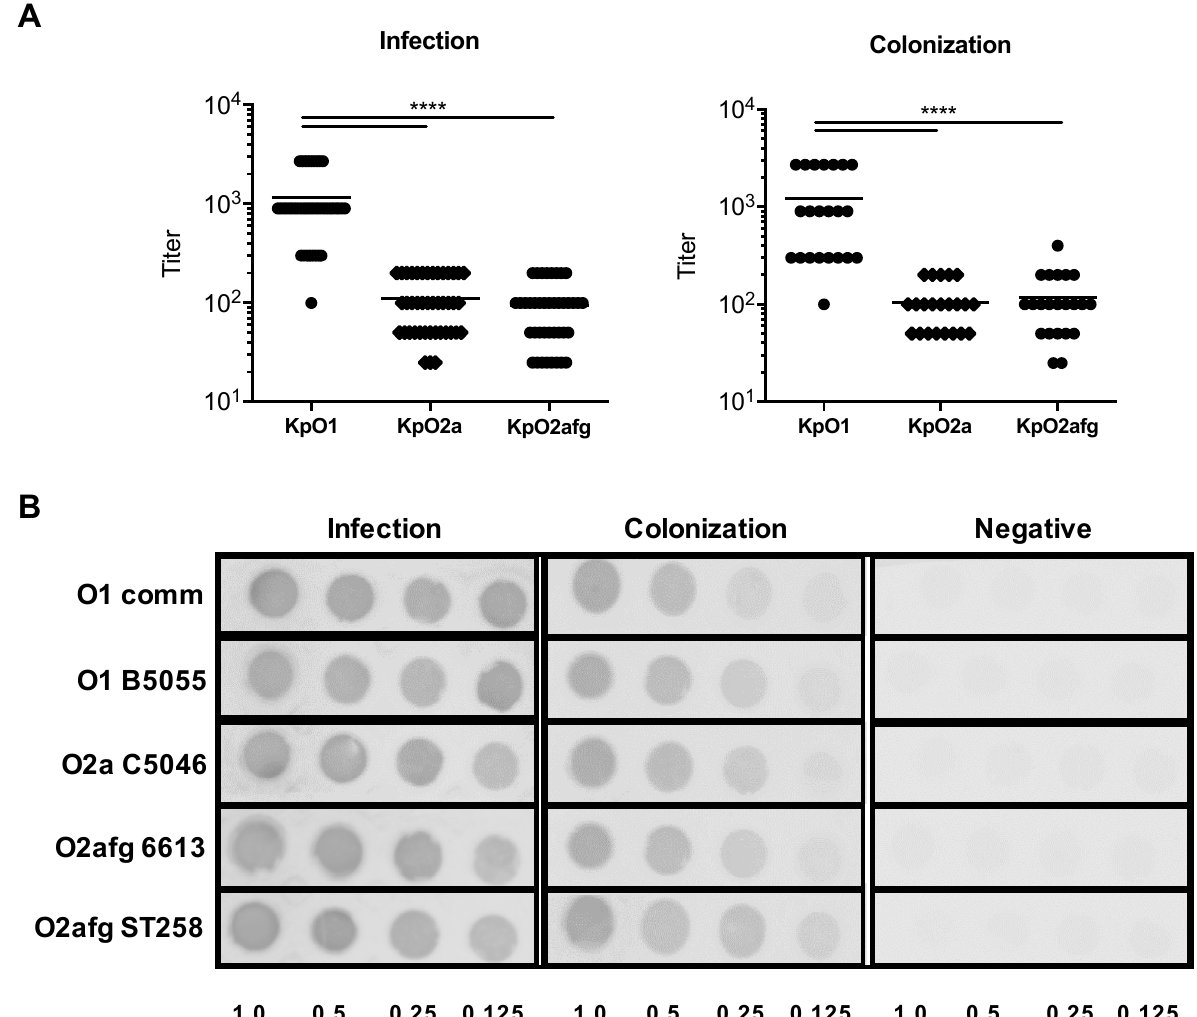
Figure 1. Following K. pneumoniae infection or colonization, titers of the antibodies against LPS O1, O2a and O2afg present in human patients’ sera were determined in infection and in colonization cases ( A ). Statistical analysis was performed using the Mann–Whitney U test, **** p < 0.0001. Immunoblots used different LPS quantities (1, 0.5, 0.25 and 0.125 µg) and sera from an infection case, a colonization patient and a negative individual at a dilution of 1:1000 ( B ).